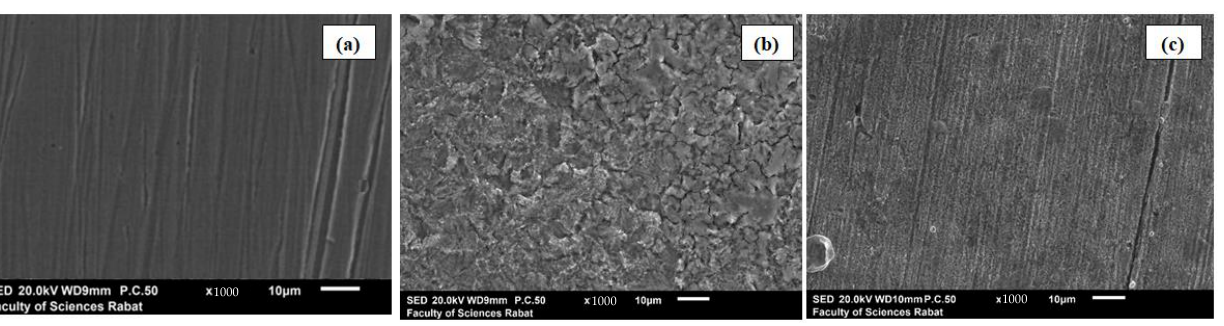
Figure 6. SEM micrographs: ( a ) metallic surface after being polished, ( b ) metallic surface after immersion in 1 M HCl alone and ( c ) metallic surface after immersion in 1M HCl + 10 −3 M PPD .